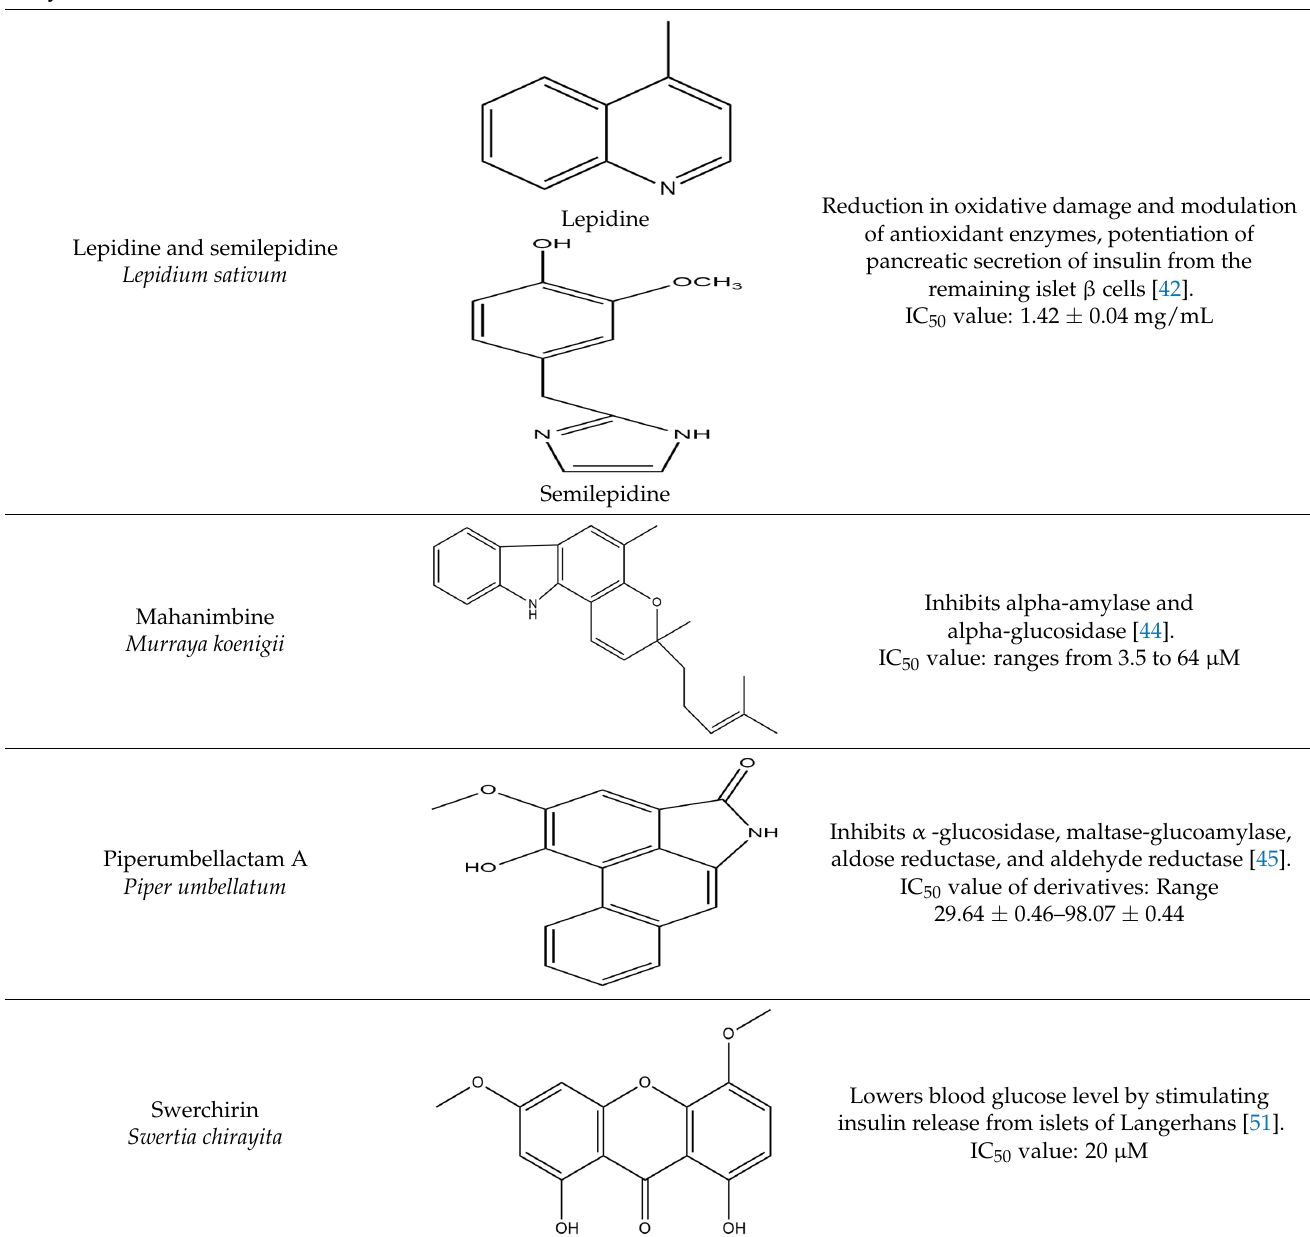
Table 1. Cont. Chemical Structure Mechanism of action